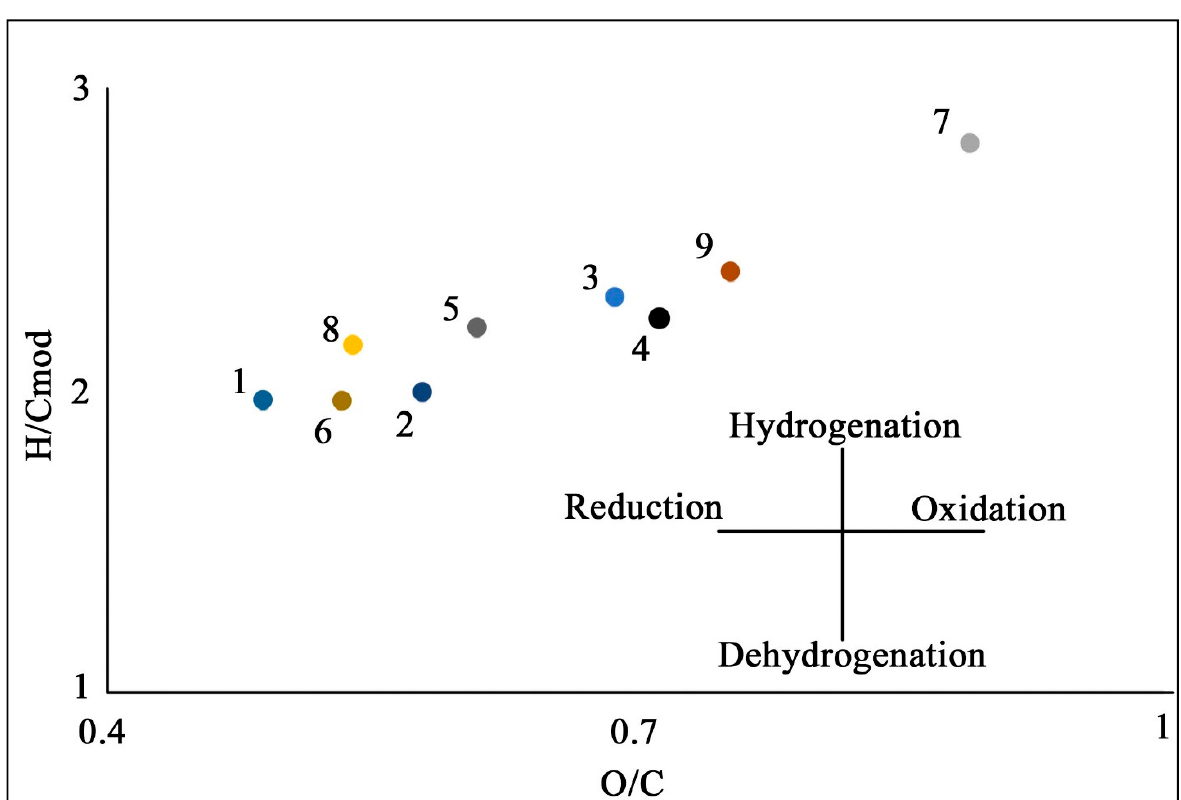
Figure 3. Elemental composition of HAs. Soil IDs correspond to Table